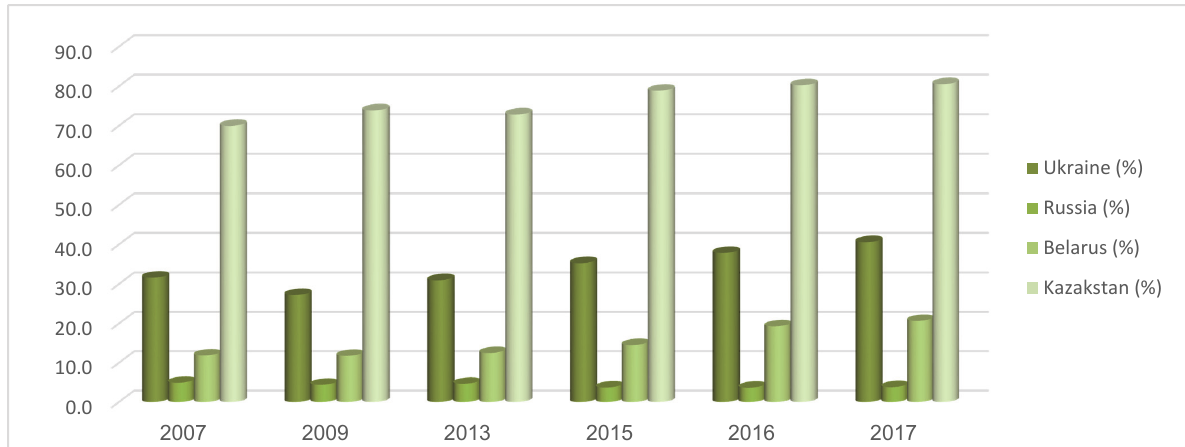
Fig. 2. Dynamics of the share of the motor transport sector in the revenues of the transport industries of key countries of the post-Soviet economic space in